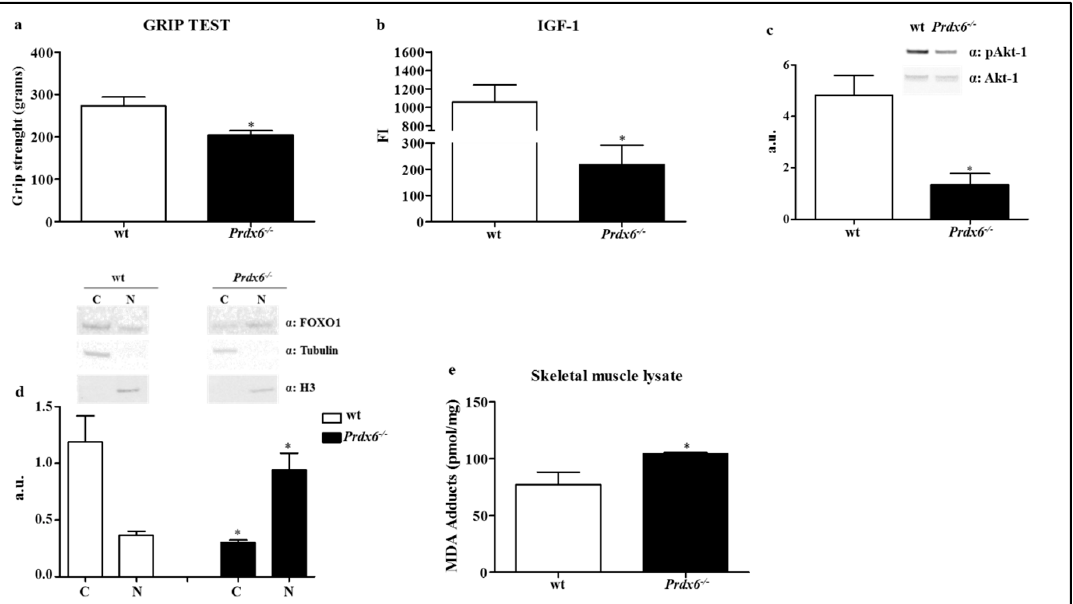
Figure 3. Absence of Prdx6 altered the IGF-1/Akt-1/FOXO1 pathway inducing Sarcopenia. ( a ) Mice muscle strength was measured by performing grip test in wt (white bar) and Prdx6 -/- mice (black bar). ( b ) Sera levels of IGF-1 were evaluated. ( c ) Akt-1 phosphorylated (pAkt-1) levels at Ser 473 were evaluated in gastrocnemius muscle lysate of Prdx6 -/- and wt mice. ( d ) Subcellular localization of